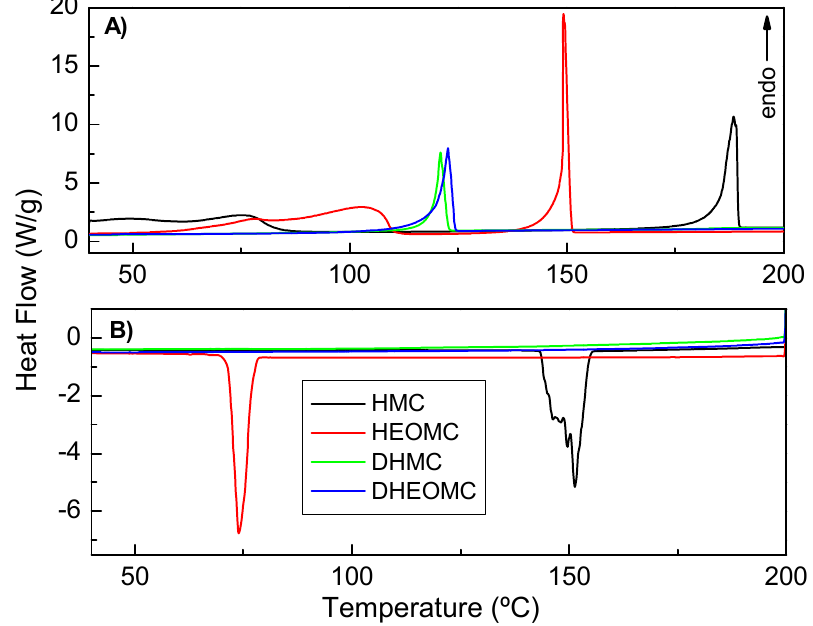
Figure 11. Differential scanning calorimetry (DSC) measurements, ( A ) heating scan, ( B ) cooling scan.